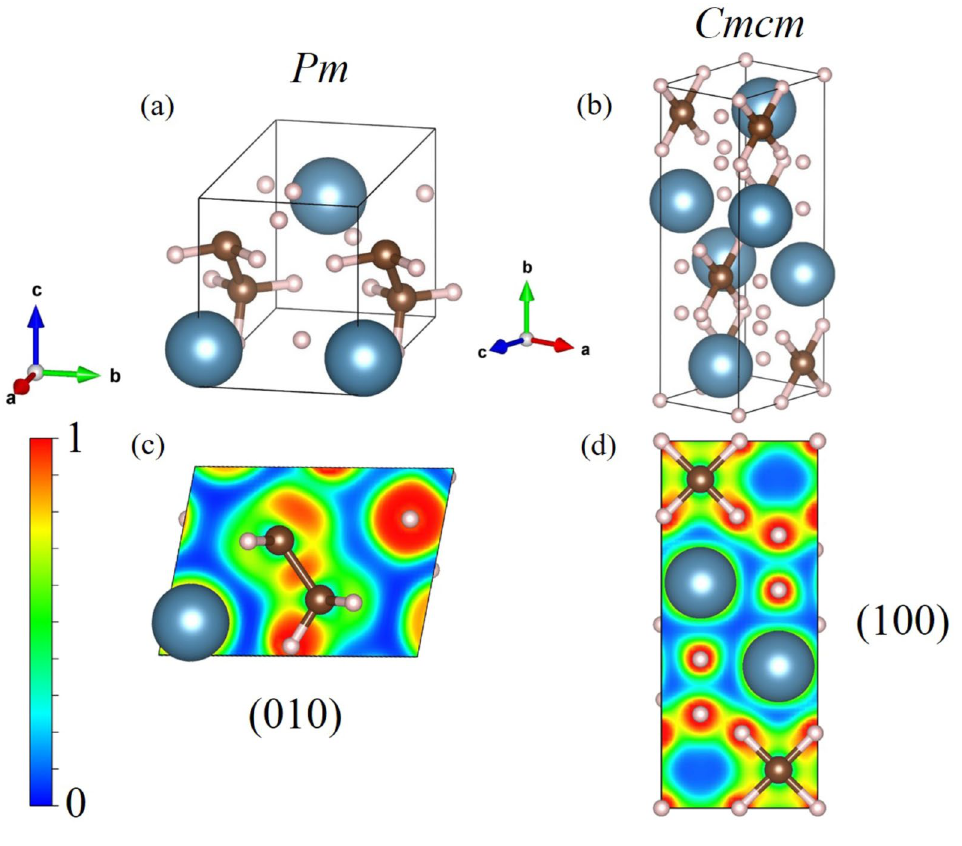
Figure 2. A schematic illustration of the Pm structure and the Cmcm structure. The Ca atoms are shown in dark blue, the C atoms in brown, and the H atoms in pink colour (drawn by VESTA (ver. 3.4.7) 56 (URL https:// jp- miner als. org/ vesta/ en/ downl oad. html)).